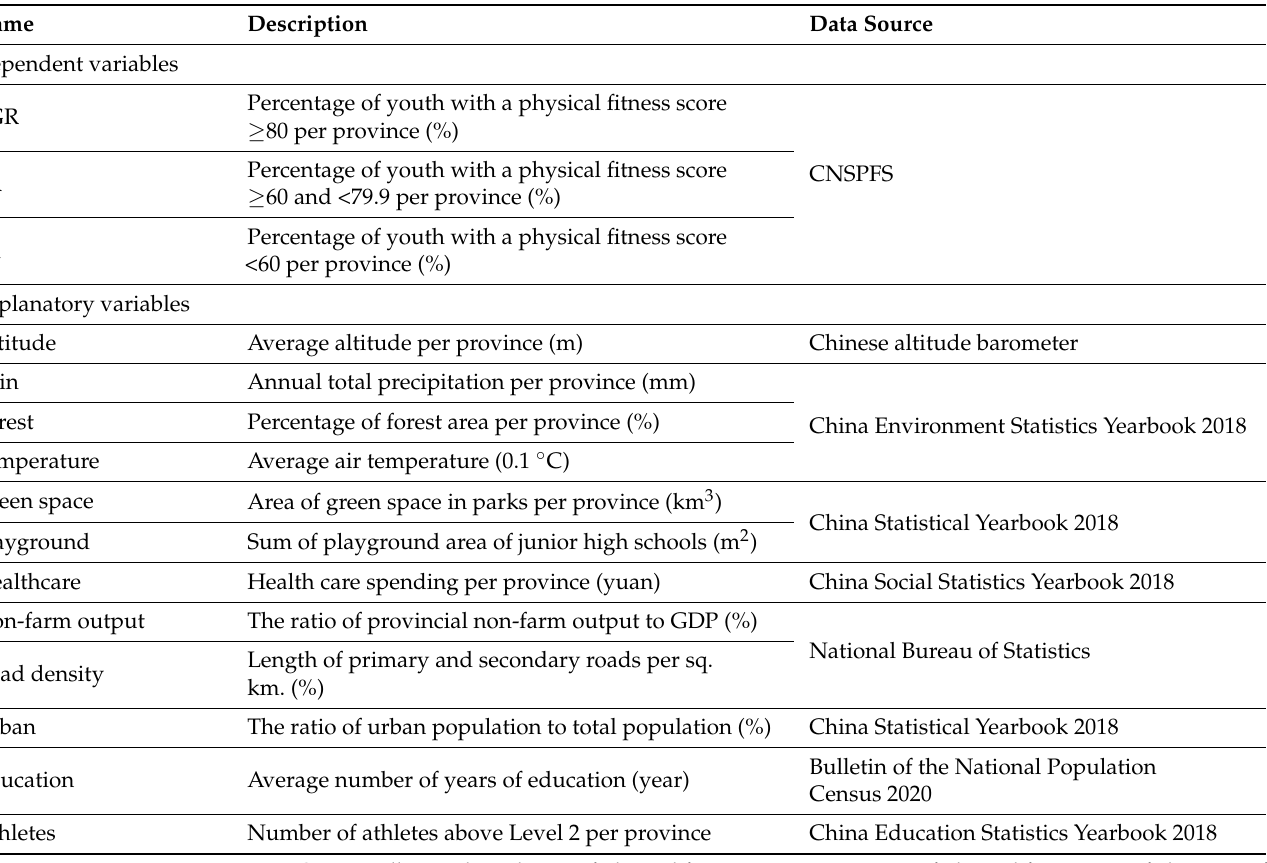
Table 1. Description of the variables and data